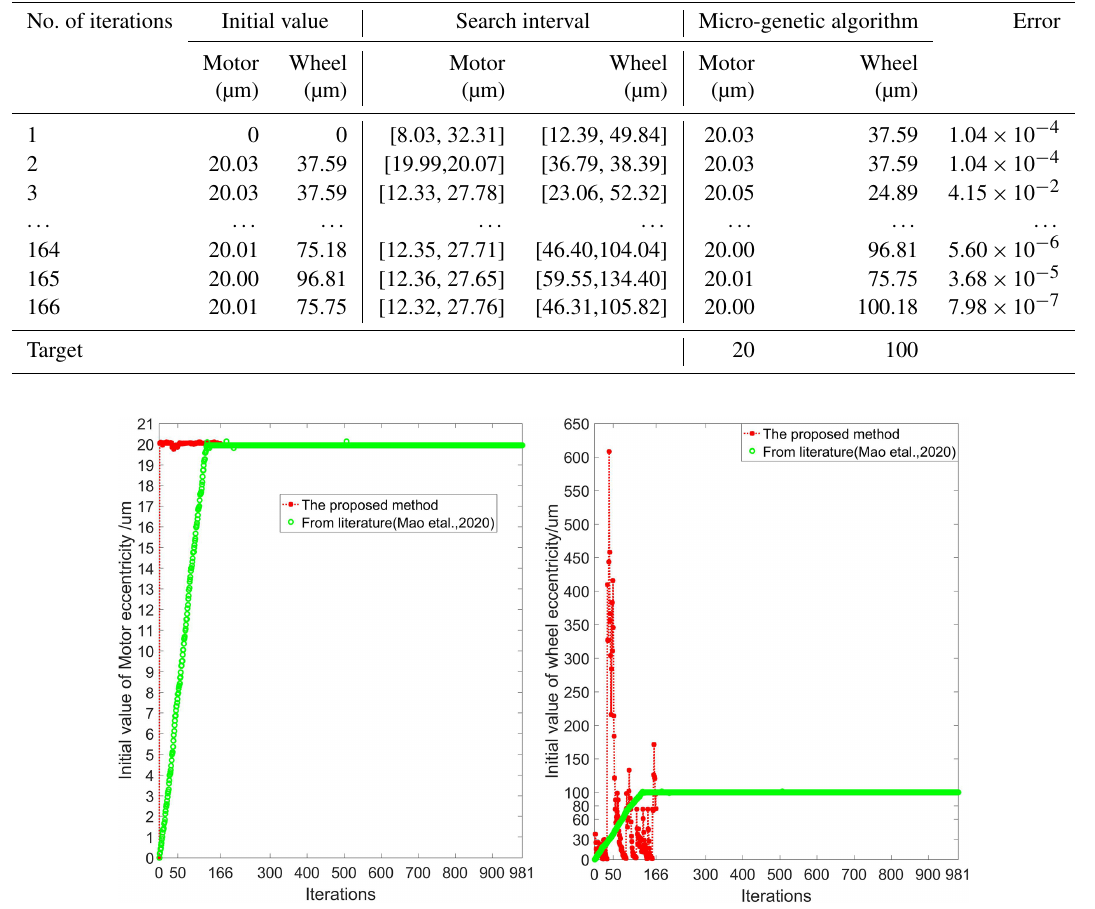
Figure 5. Comparison of the iterative process of initial